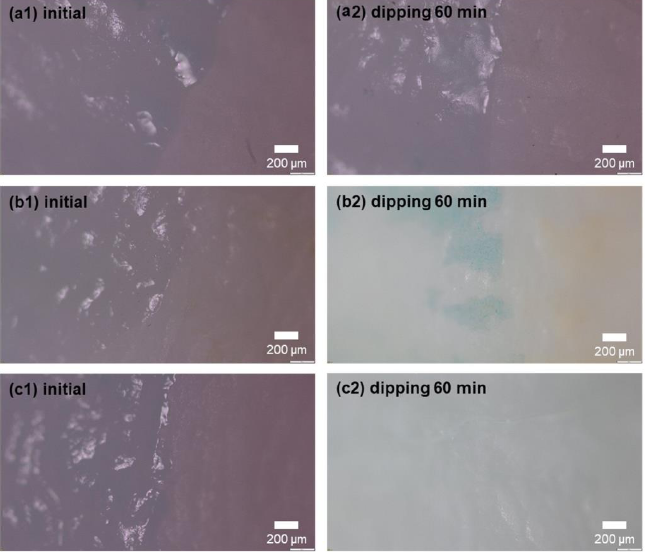
Figure 4. Digital optical microscopy images of initial and dipping 60 min of tooth whitening com- positions coated on bovine teeth: ( a ) PVAc-H 2 O 2 , ( b ) EC-H 2 O 2 , and ( c ) PVP-H 2 O 2. The AFM images revealed a smooth coating of PVAc-H 2 O 2 on the bovine tooth sur- face (Figure 5a). After drying, a uniformly coated surface was obtained without any ob- servable clumps or agglomeration. The parameters of average roughness (Ra) and root- mean-square roughness (Rq) of the coating side were 7 nm and 14 nm, respectively. The coating on the tooth was peeled off using a double-sided tape and observed by AFM to examine the surface of the tooth coating on the attachment. Unlike the coating on the tooth surface, the film of the tooth-whitening composition coated on the attachment side exhib- ited pseudo-isomorphic morphology with the bovine tooth surface. The Ra and Rq of the attachment side were 135 nm and 168 nm, respectively. The pristine bovine teeth surface exhibited Ra and Rq values of 123 nm and 154 nm, respectively (Figure S2). The obtained AFM images confirmed that the PVAc-H 2 O 2 tooth-whitening composition coated on the surface of the bovine teeth retained its initial morphology (Figure 5b). Additionally, the coated film has specific surface morphology and excellent wettability and, hence, is ex- pected to exhibit a significant tooth-whitening effect [30,31].